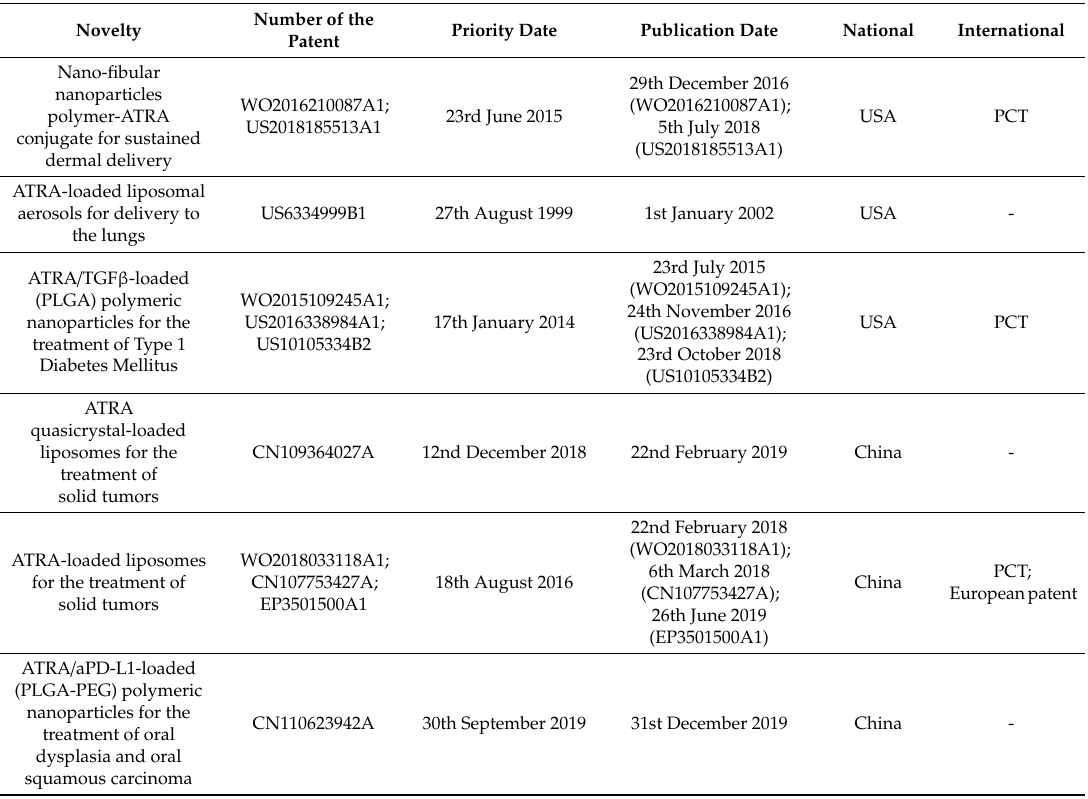
Table 2. Patents related to ATRA delivery systems in